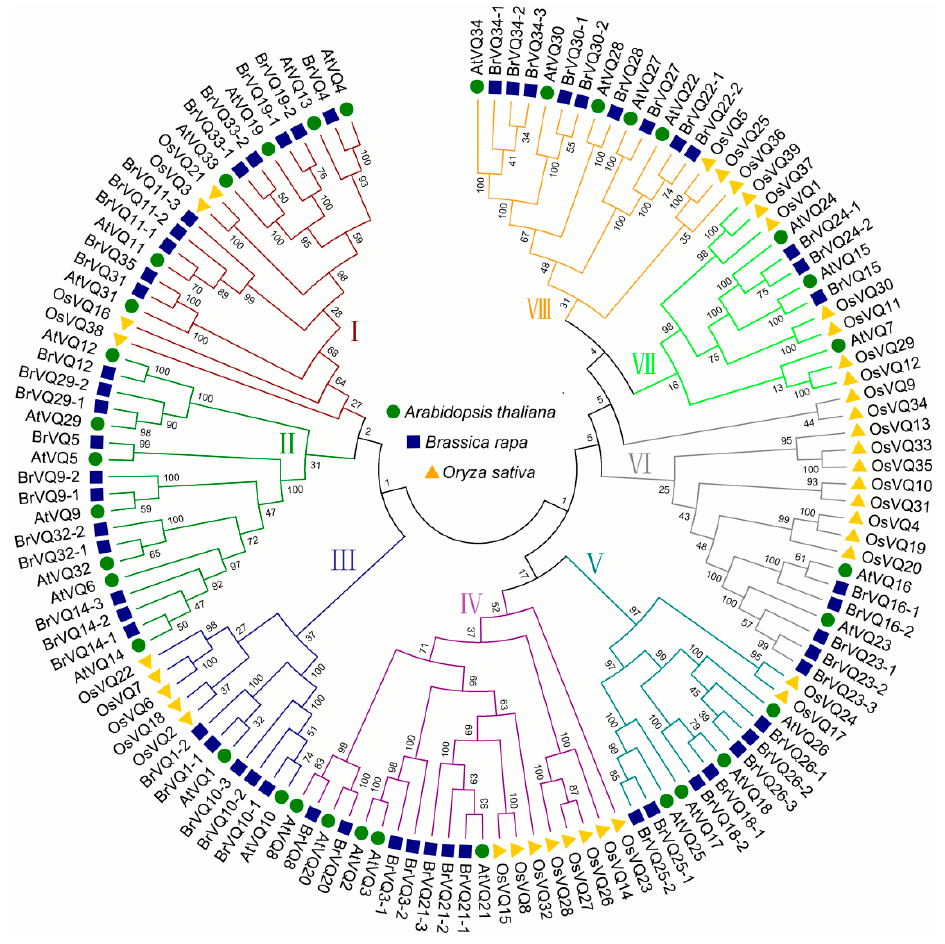
Figure 6. Phylogenetic tree of the VQ motif–containing proteins from Arabidopsis , rice, and Chinese cabbage. The tree was determined using the neighbor-joining method with 1000 bootstrap replicates. Based on the clustering of the VQ motif–containing proteins, we classified proteins into eight different groups from Group I to Group VIII. Proteins from Arabidopsis , Chinese cabbage, and rice are denoted by green circles, blue squares, and yellow triangles, respectively.